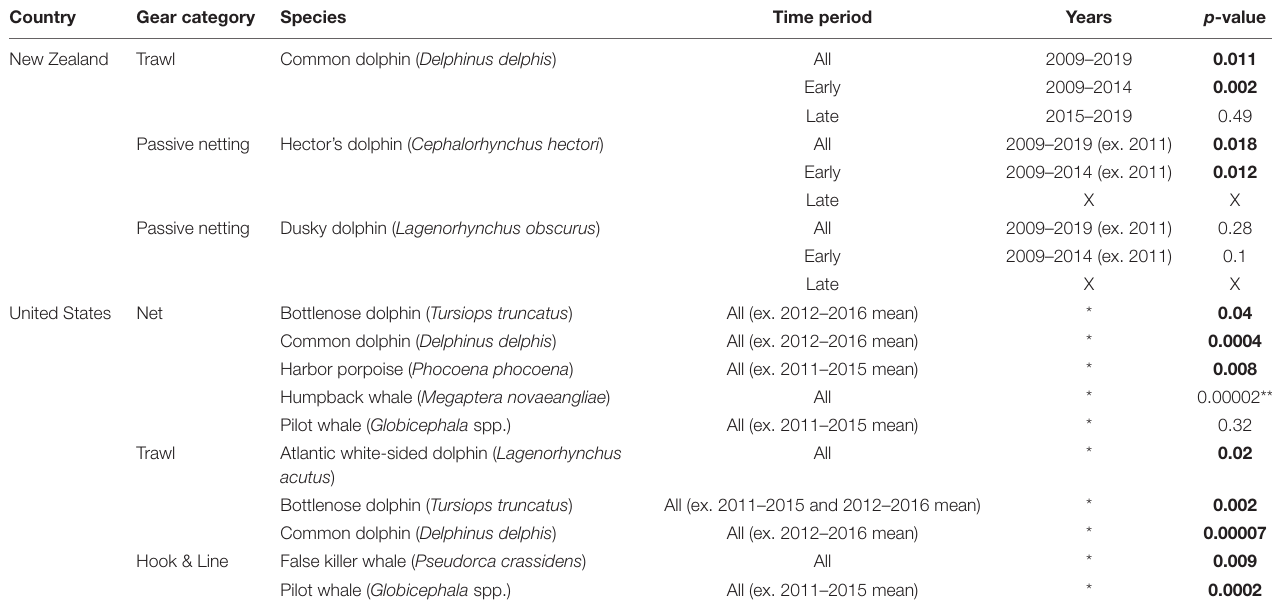
TABLE 5 | p -value results of paired t -test/Wilcoxon tests determining if fisher reported CPUE is significantly lower than observer reported CPUE (New Zealand) and if fisher reported annual average number of individuals caught based on 5-year time blocks is significantly lower than observer reported annual average number of individuals caught based on the same 5-year time blocks (United States) for the most commonly reported species in specific gear